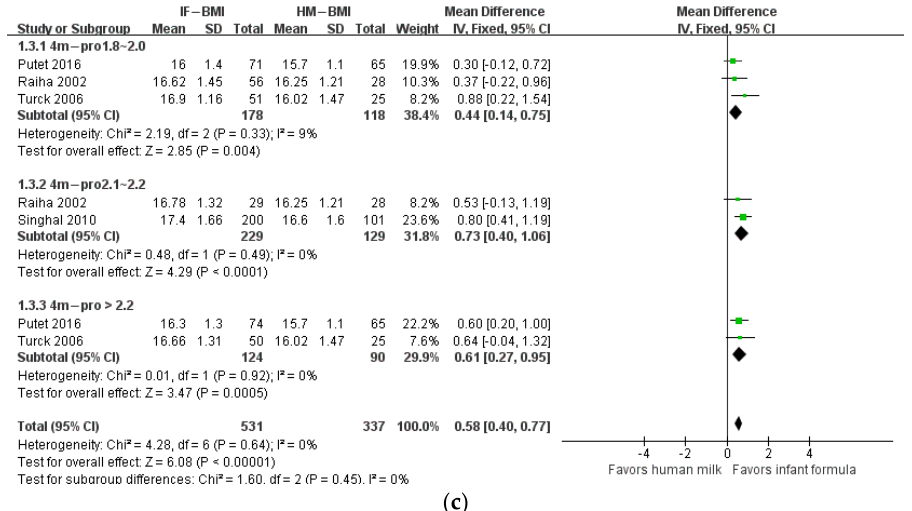
Figure 5. Forest plot of the effects of protein content of infant formula on the weight gain, height gain, and BMI of infants at 4 months of age. ( a ) The effects on weight gain. ( b ) The effects on height gain. ( c ) The effects on BMI.